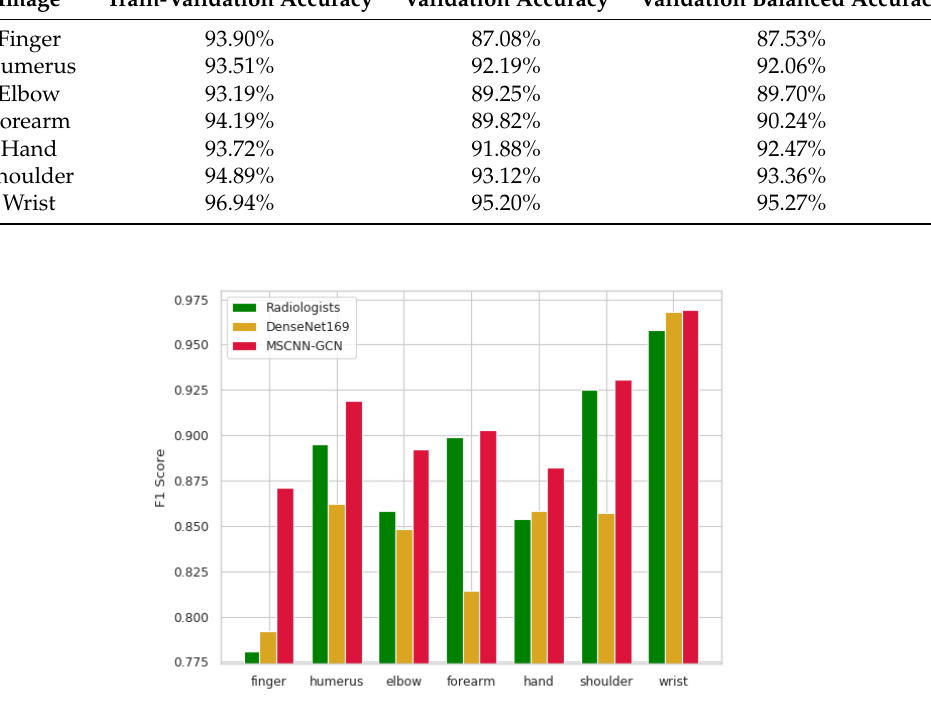
Figure 4. F1 scores of radiologists, DenseNet169 and the proposed